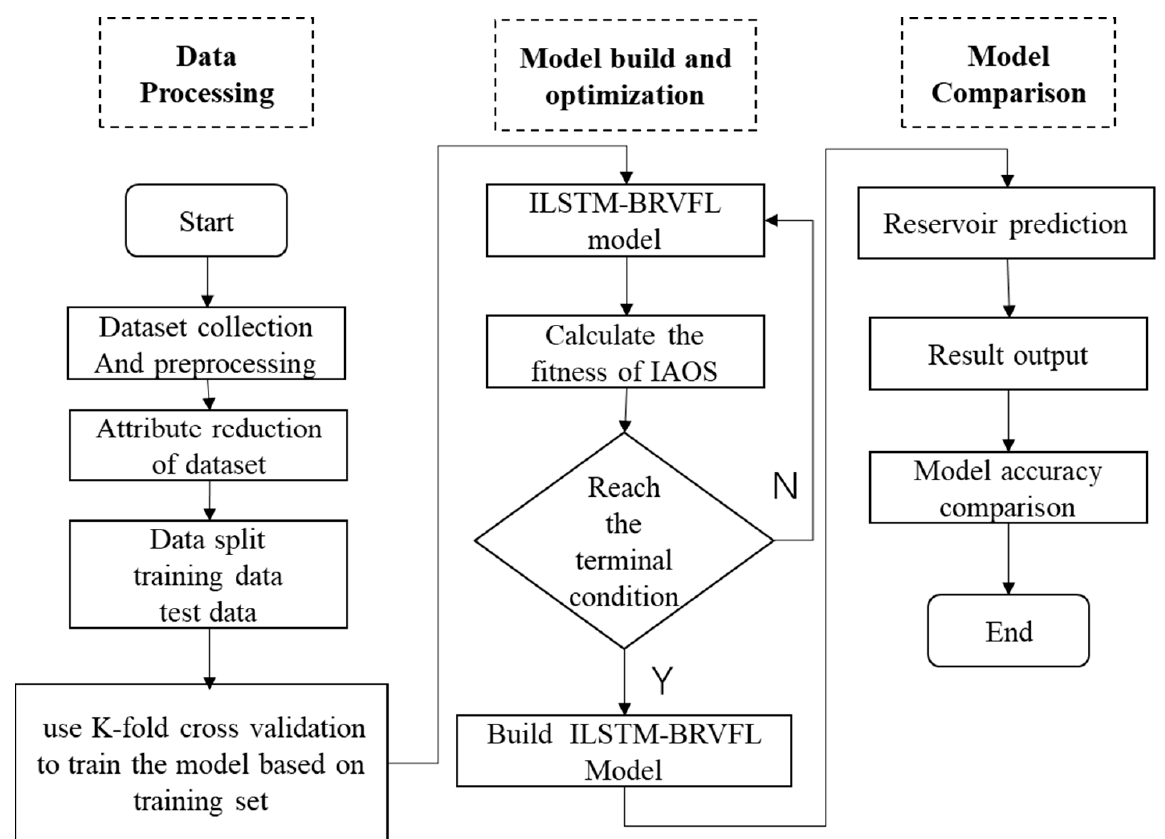
Figure 6. Flowchart of oil layer prediction.